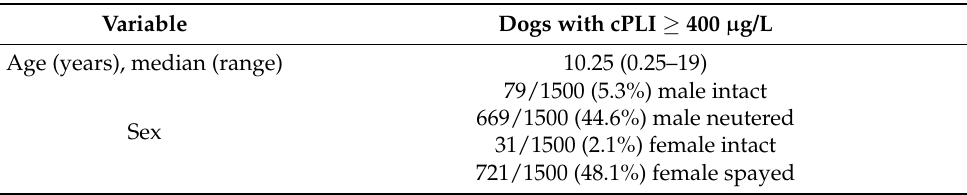
Table 1. Demographic details on the survey population. Note: Age was unavailable for 65 dogs. Sex status was unavailable for 31 dogs. Breed was unavailable for 45 dogs. Rounding resulted in a total > 100% for